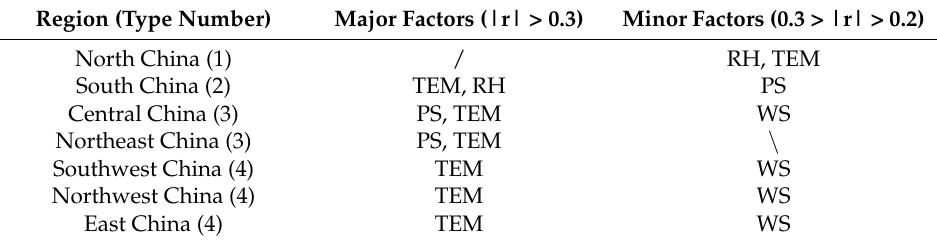
Table 2. The major and minor influencing factors of the seven